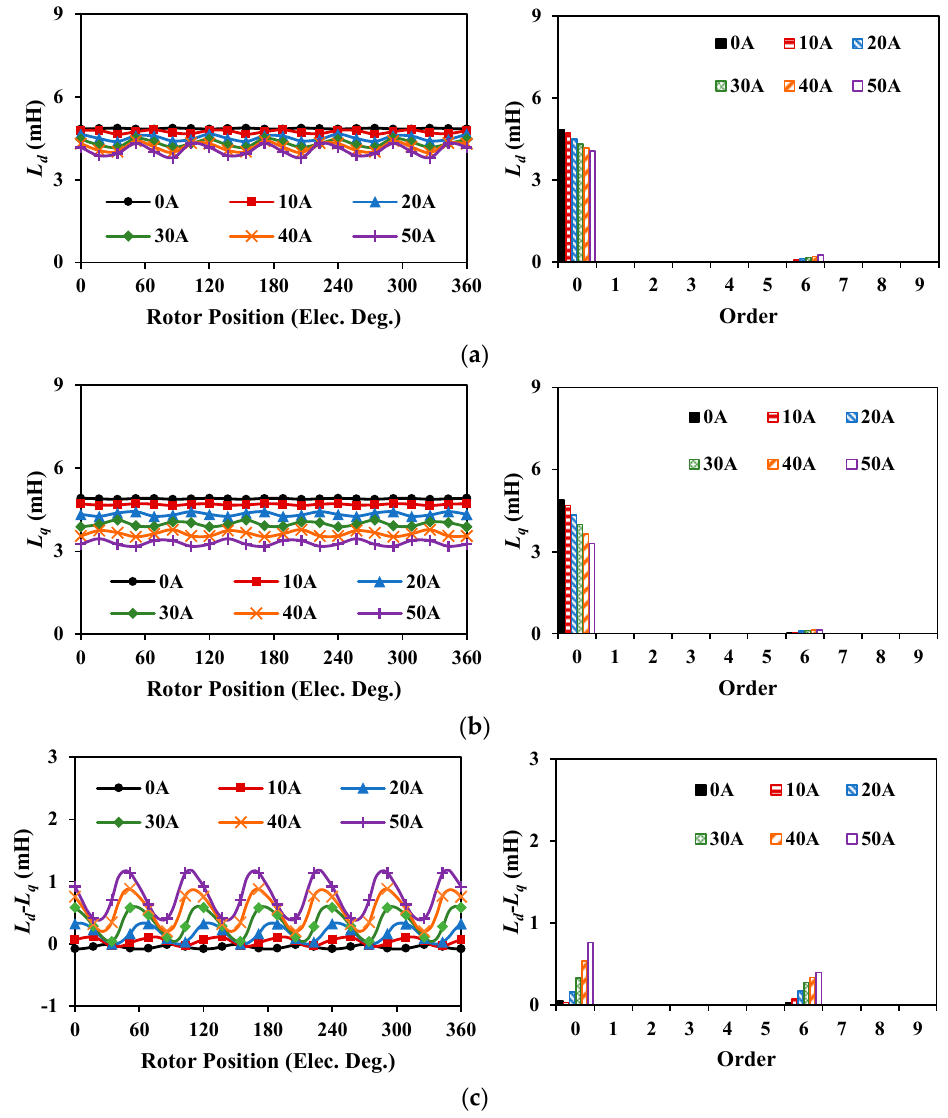
Figure 16. Inductances and spectra for 12s8p SPM machine. ( a ) L d . ( b ) L q . ( c ) L d - L q .